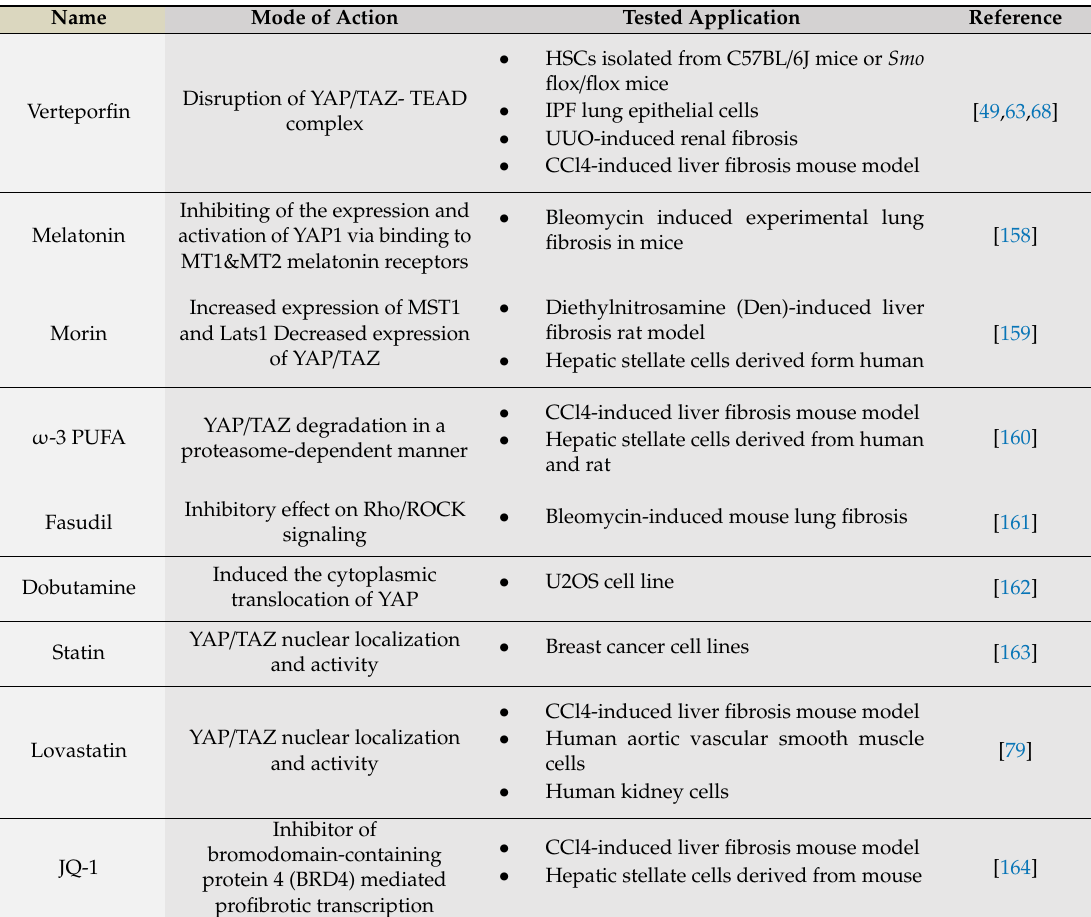
Table 1. Potential targets for e ff ective Hippo pathway